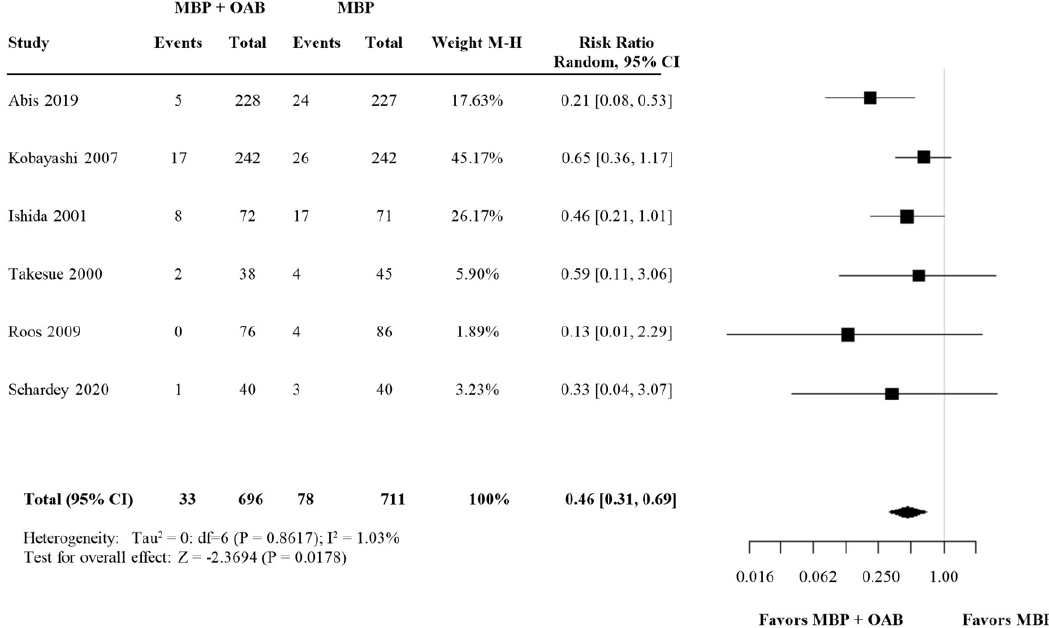
Figure 3. Forest plot comparing SSI rate for patients receiving OABs in addition to MBP and i.v. antibiotic prophylaxis versus MBP with i.v. antibiotic prophylaxis. A random effects model was used to perform the meta-analysis and risk ratios are quoted including 95% confidence intervals.